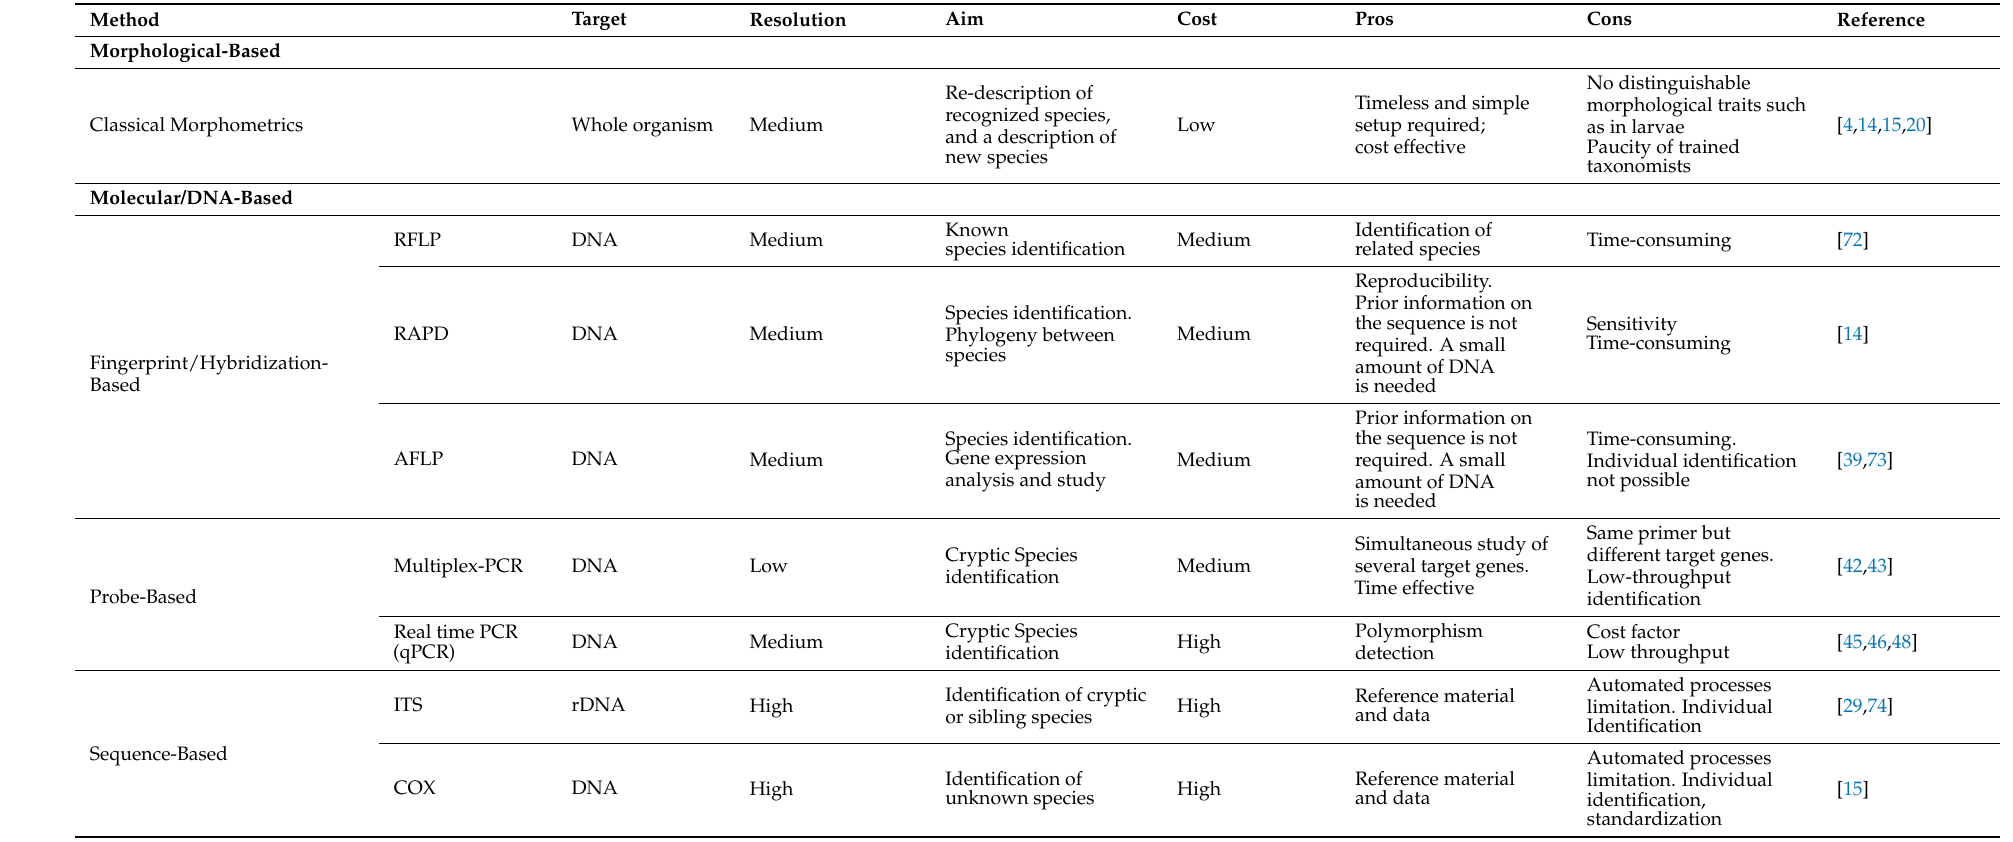
Table 1. Emerging trends in nematode identification (different methods used for known and unknown nematode